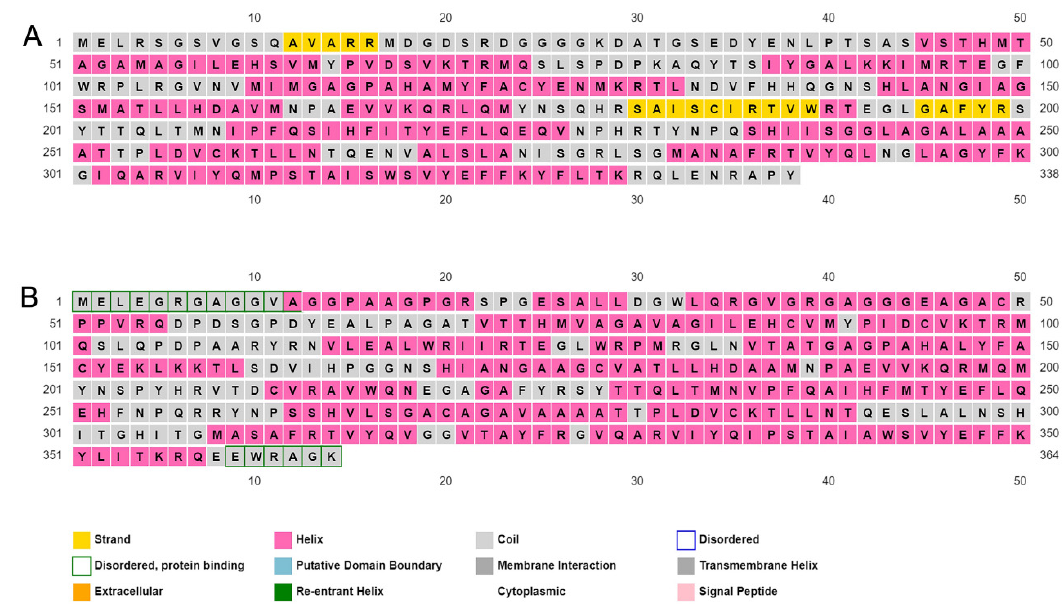
Figure 2. Predicted secondary structures of human mitoferrin-1 ( A ) and mitoferrin-2 ( B ). The protein sequences were analyzed using PSIPRED to identify protein secondary structure. The predicted alpha-helices, beta-strands, coiled coils, and disordered regions are indicated by unique colors, as detailed in the legend below each